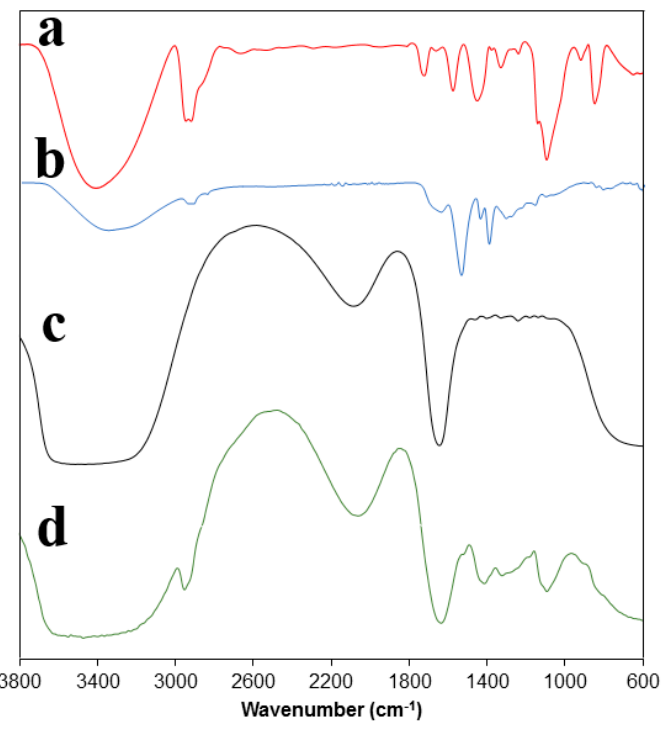
Figure 5. Fourier Transform Infrared (FTIR) spectra of ( a ) PVA; ( b ) PVA-PAA; ( c ) Tetracycline; and ( d ) PVA-tetracycline.